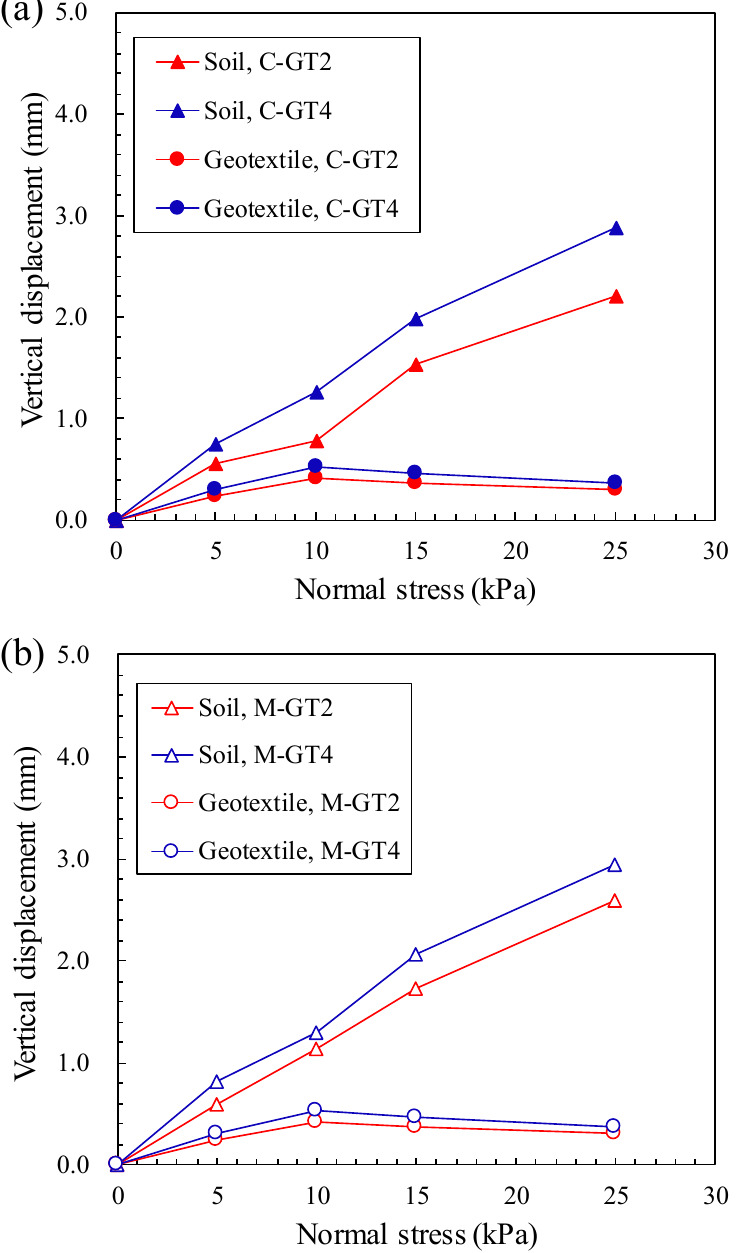
Figure 7. Downward displacements for soil–geotextile combinations subjected to normal stresses: ( a ) C-GT2/GT4 combinations; ( b ) M-GT2/GT4 combinations. The fine particles retained ( η ) of the four soil–geotextile combinations at different normal stresses are shown in Figure 8. The η values were closely related to the soil type and geotextile thickness. The fine particles retained ( η ) of the four soil–geotextile combinations increased with an increase in normal stress. When the normal stress was 0 kPa, the η values of C-GT2, M-GT2, C-GT4, and M-GT4 were 271 g/m 2 , 465 g/m 2 , 605 g/m 2 , and 610 g/m 2 , respectively. When the normal stress was increased to 25 kPa, the η values of C-GT2, M-GT2, C-GT4, and M-GT4 increased by 96%, 53.8%, 39.8%, and 53.9%, compared with those free of normal stress. This was mainly because, when the normal stress in- creased, soil layer settlement increased, and the structure of fibers became denser, result- ing in an increase in the η values. Comparing the results from GT2 and GT4 combinations,